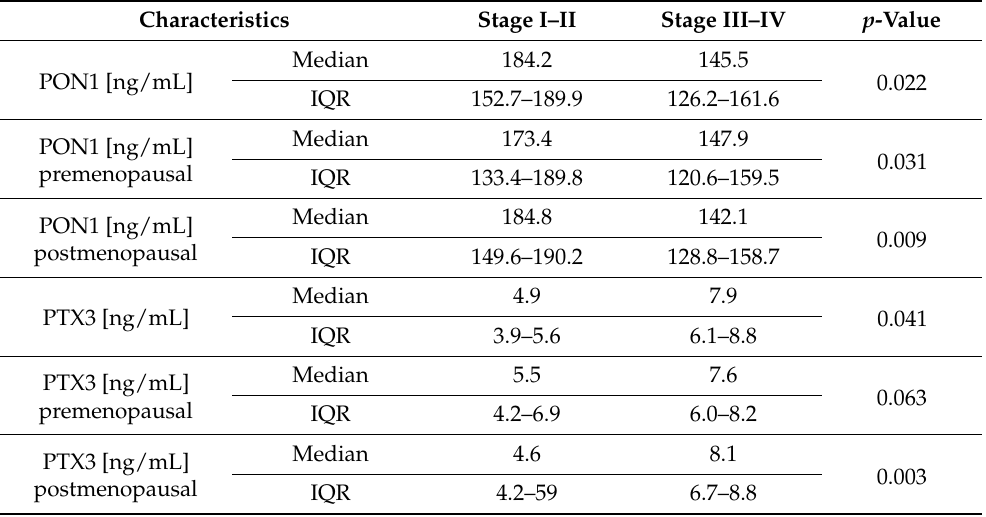
Table 5. Comparison of PON1 and PXT3 levels between patients with stage I–II and stage III–IV endometrial carcinoma.